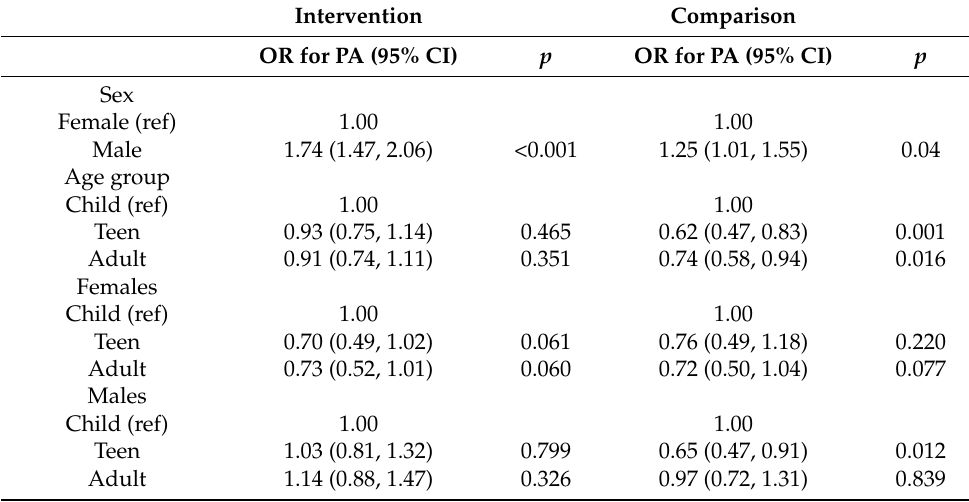
Table 4. Odds ratios for any PA associations between observed park visitation characteristics and PA between district and community intervention and comparison